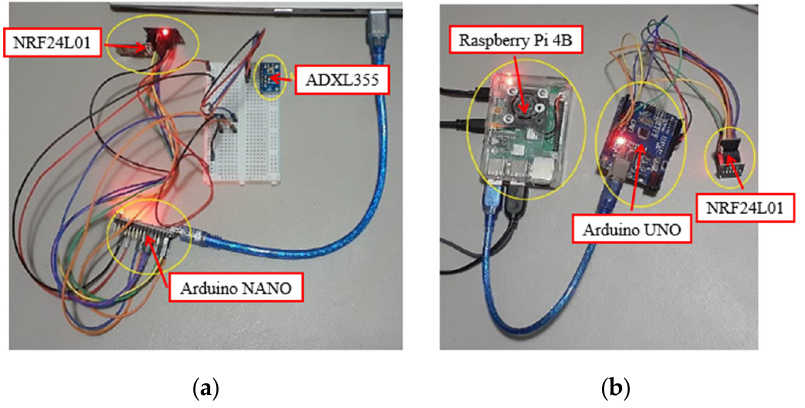
Figure 4. Used low-cost equipment for: ( a ) registration and ( b ) elaboration and transmission of data. For the elaboration and transmission of data, the same accelerometer and “NRF24L01” device were used with the “Arduino NANO” device for the transmission, and the micro-computer “Raspberry Pi 4B” (see point A in Figure 1a) and microcontrollers “Arduino UNO” (Figure 4b) device for the elaboration/visualisation.